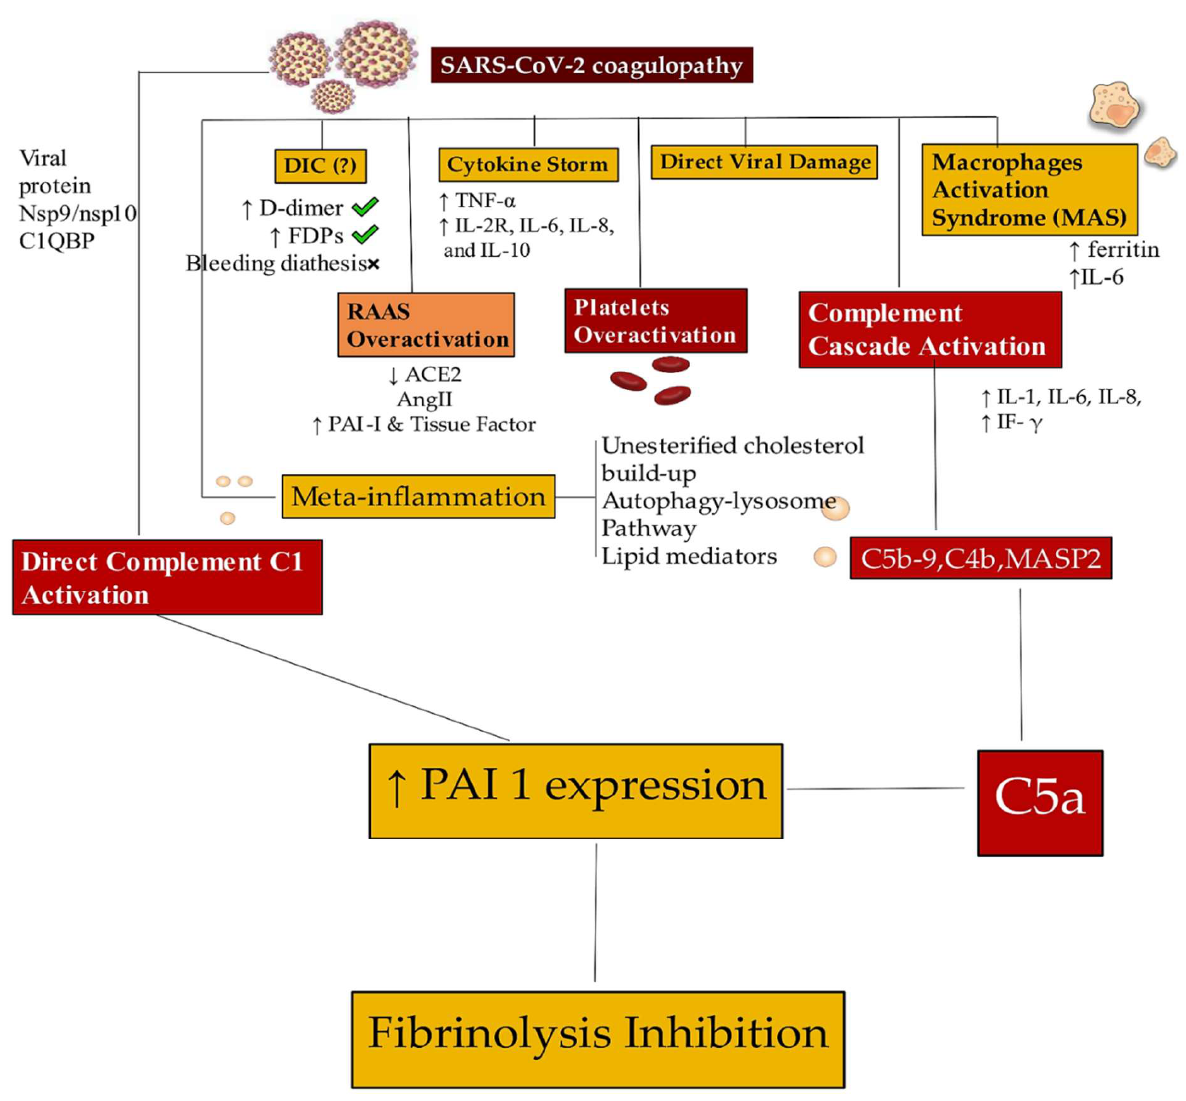
Figure 5. Only a residual proportion of patients with COVID-19 have a diagnosis of viral myocarditis documented by the presence of SARS-CoV-2 in myocardiocytes. The most frequent lesions are induced by the development of micro- and macrothrombi. In patients with COVID-19, micro- and macrothrombotic formations localized both in the microcirculation and in the epicardial vascular system of the heart have been observed. SARS-CoV-2 infections promote dysregulation in the coagulation system, and several mechanisms are implicated. The coagulopathy is supported by the DIC, the cytokine storm process, and the direct action of the virus, which proves the damage and activation of macrophages. Hyperactivation of the RAAS associated with platelet and complement hyperactivation (direct and indirect) leads to inhibition of fibrinolysis. Abbreviations: ACE2, angiotensin-converting enzyme 2; C, complement; DIC, disseminated intravascular coagulation; FDP, fibrinogen-derived peptides; IFN- γ , interferon gamma; IL, interleukin; MAS, macrophage activation syndrome; PAI, platelet activator inhibitor; TNF, tumor necrosis factor; RAAS, renin-angiotensin-aldosterone system. The arrows explain the increase or decrease of the related component. ↑ , increases; ↓ , decreases. When to do the endomyocardial biopsy